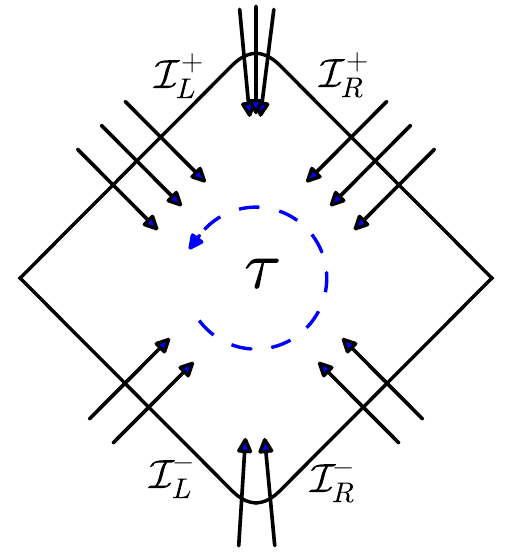
Figure 1 . Particles at the asymptotic boundary of Minkowski space. Arrows correspond to on- shell two-momenta. (cid:28) is the coordinate parametrizing the boundary and ordering is given by the rapidities as described in the